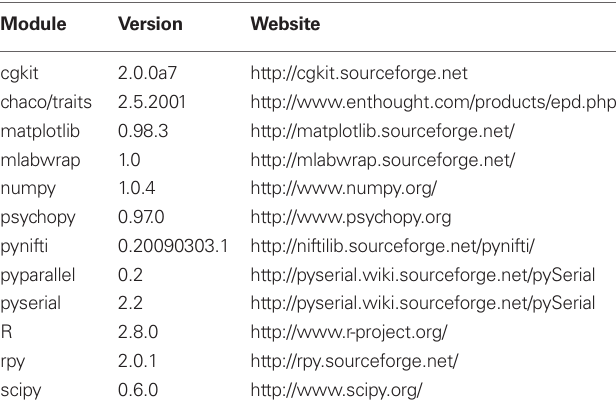
Table 3 | Versions utilized and website information for major modules and tools used in the NinPy tool